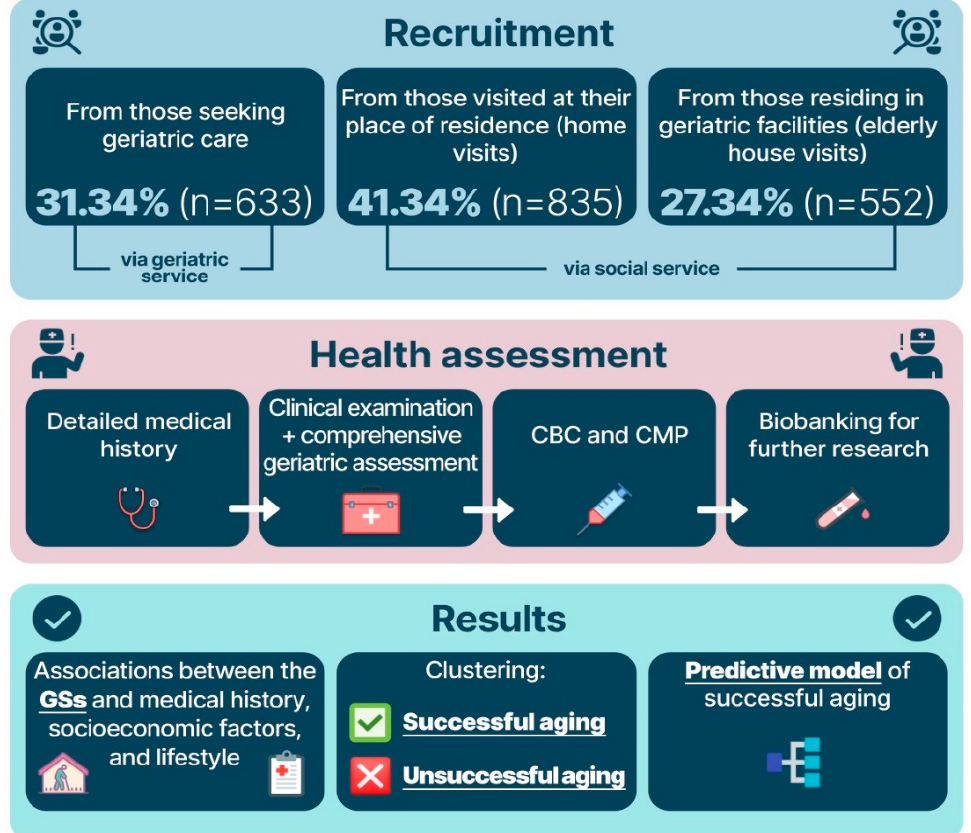
Figure 1. Participant recruitment and study design. Note: CBC—complete blood count; CMP— comprehensive metabolic panel; GSs—geriatric syndromes.